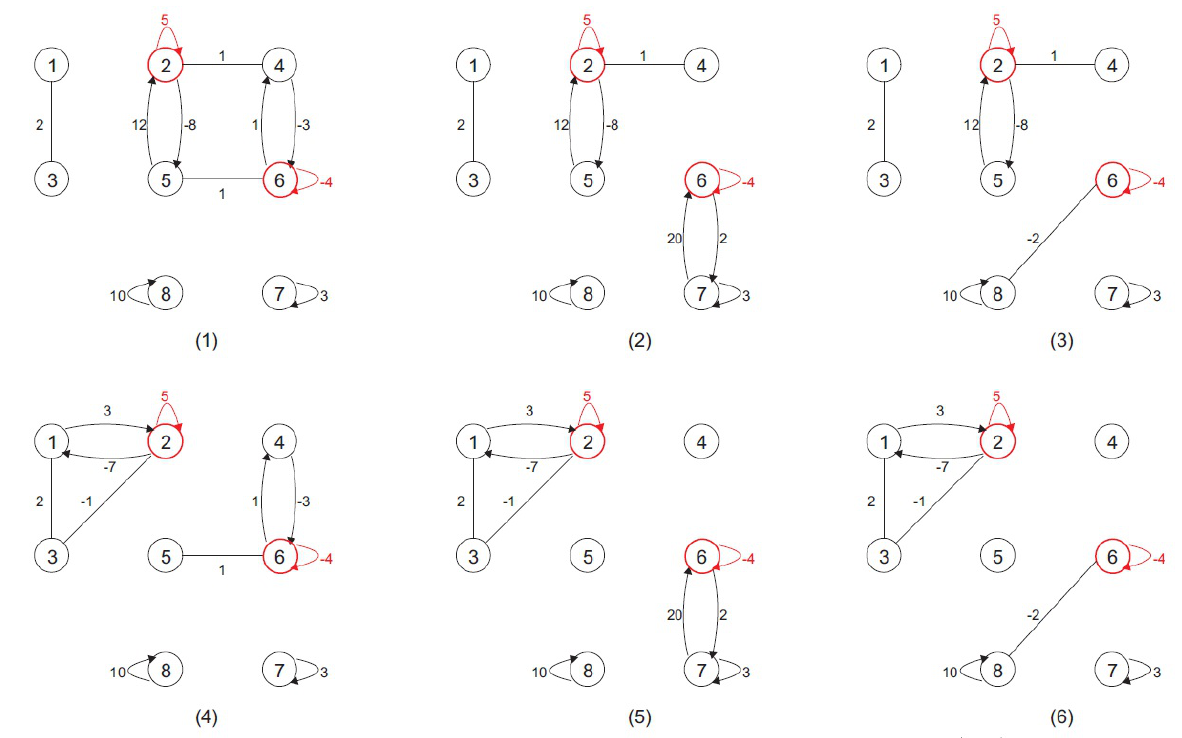
Figure 5: B -partitions of the digraph of matrix M